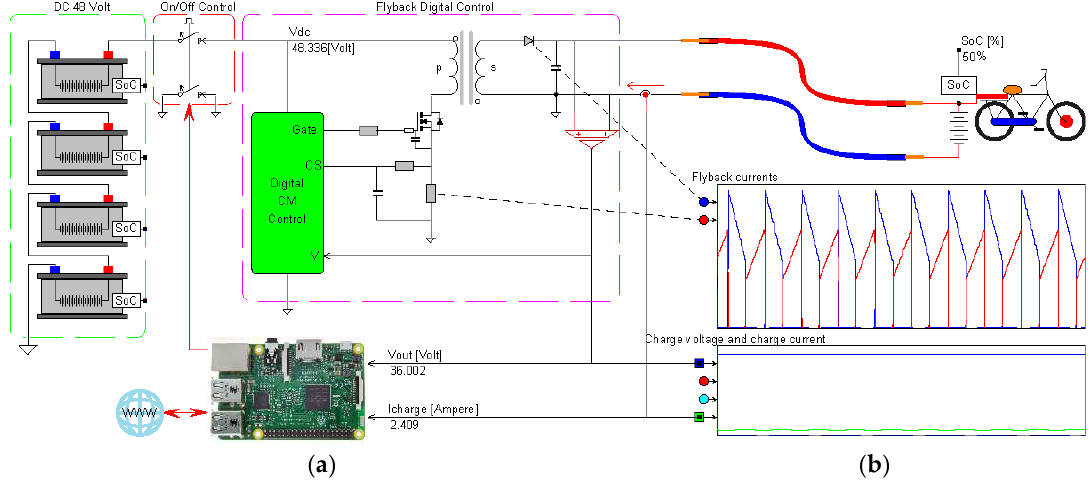
Figure 7. ( a ) Flyback converter for e-bike battery charging with a digital current mode control and charging current monitoring and logging. ( b ) Simulation results show the primary (red) and secondary (blue) current as well as the charge voltage (V out = 36 Volt) and charge current (I ch = 2.4 Ampere) for the 48-volt DC grid, and operating in a continuous conduction mode.